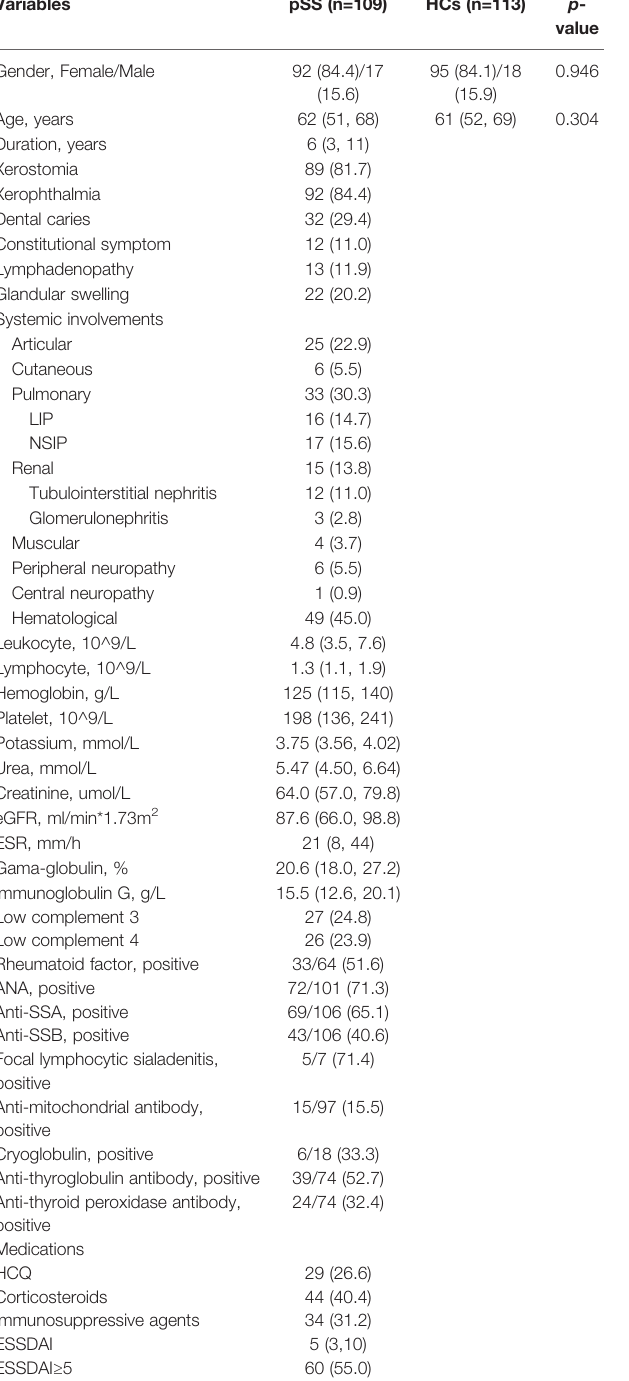
TABLE 2 | Levels of tumor markers between patients with primary Sjögren ’ s Syndrome (pSS) and healthy controls (HCs). Marker pSS (n=109)